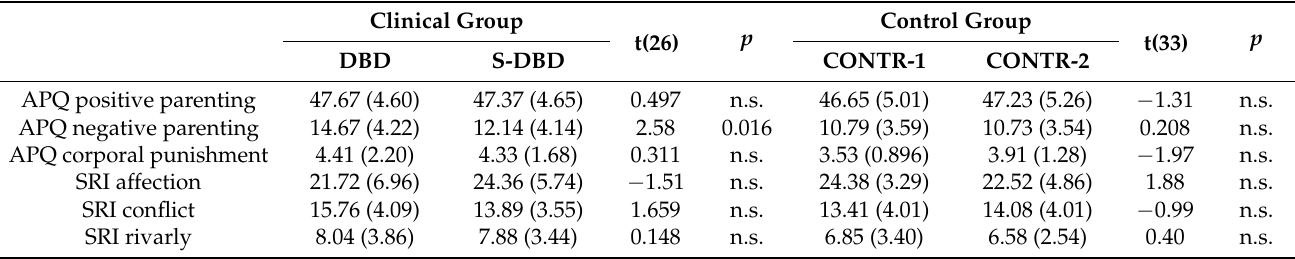
Table 2. Mean (SD) reported by clinical sibling (DBD), non-clinical sibling of clinical family (S-DBD), control sibling 1 (CONTR-1) and control sibling 2 (CONTR-2) in APQ and SRI subscales. Results of t test are reported for both groups.